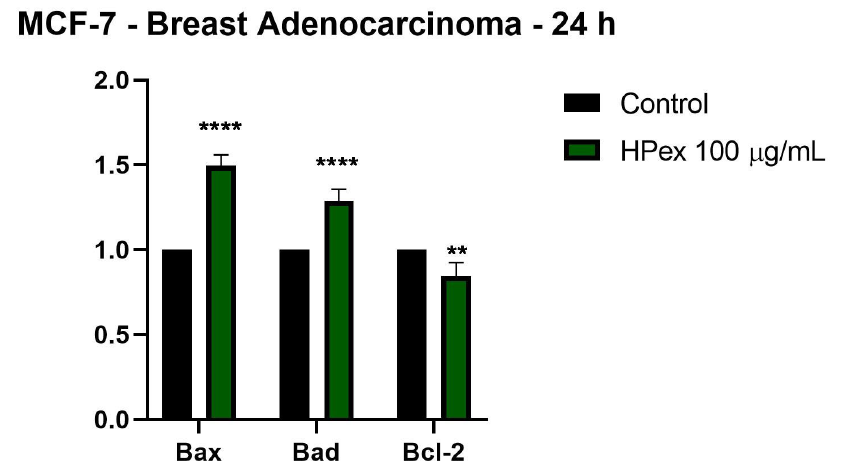
Figure 4. Relative fold change expression of mRNA of pro-apoptotic (Bax and Bad) and anti-apoptotic (Bcl-2) markers in breast adenocarcinoma (MCF-7)—24 h after exposure to HPex 100 µ g/mL. mRNA expression levels normalized to 18 S expression, mean values ± SD of three independent experiments presented, one-way ANOVA with Tukey’s post-test used to identify the statistical differences (** p < 0.01 and **** p < 0.0001).